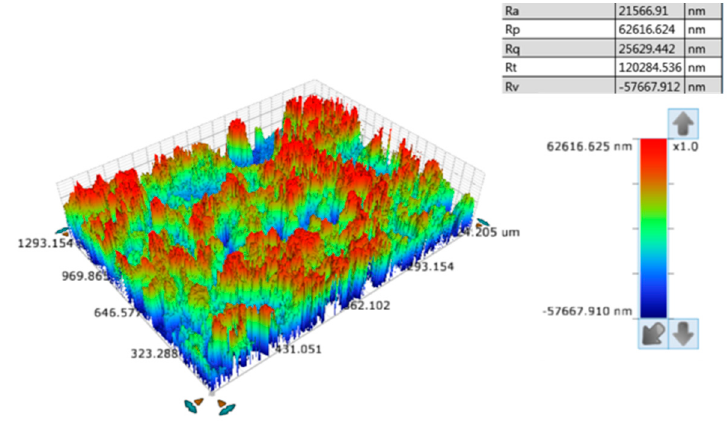
Figure 3. The roughness of the coating.